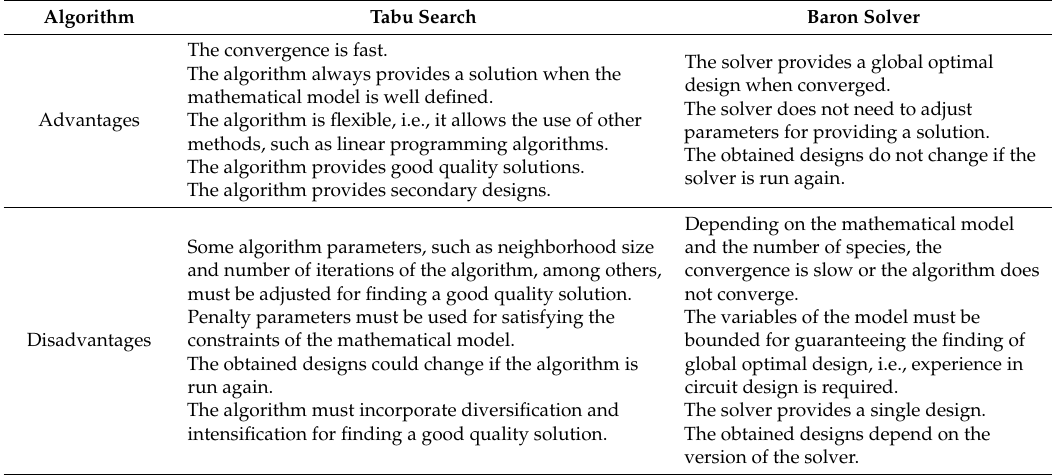
Table 8. Comparison between the Tabu-search algorithm and the Baron